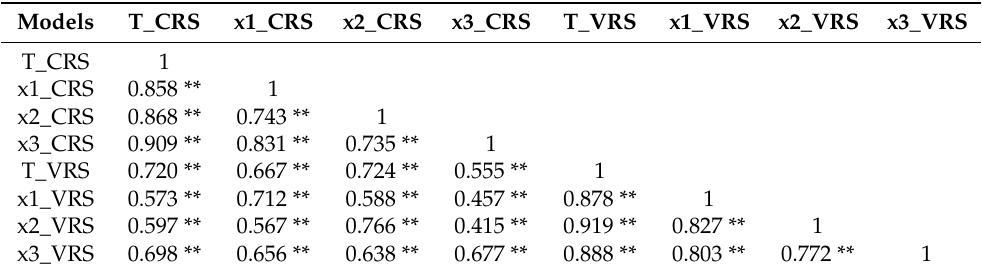
Table 5. Correlation matrix.